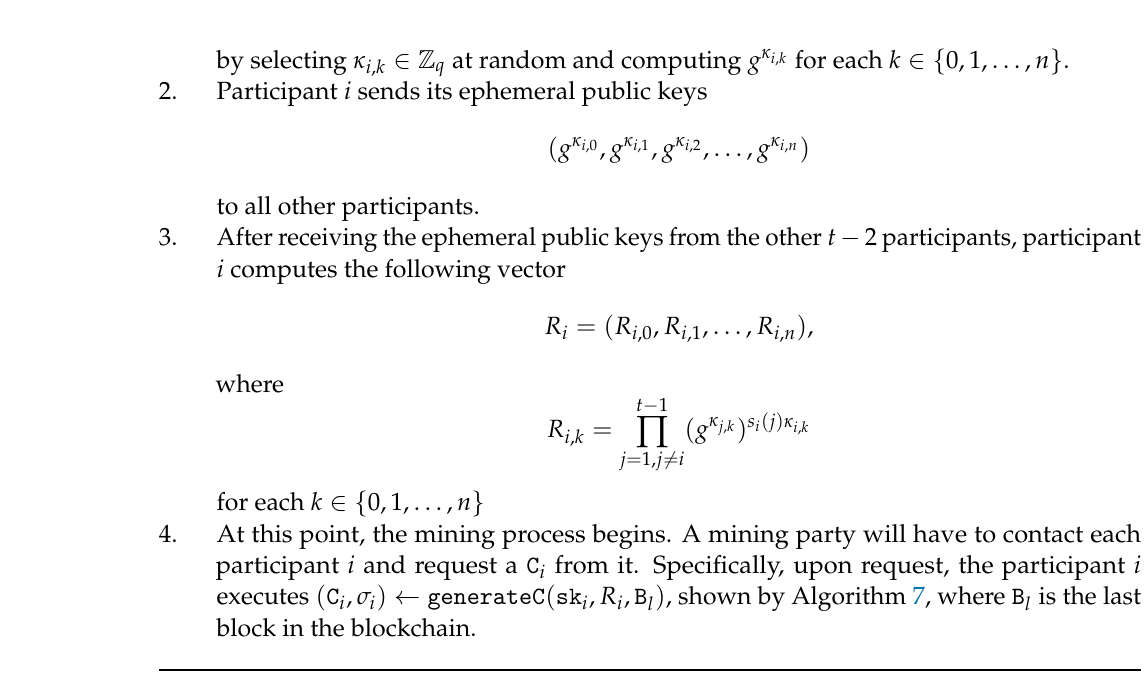
Algorithm 7 generates the pair ( C i , σ i